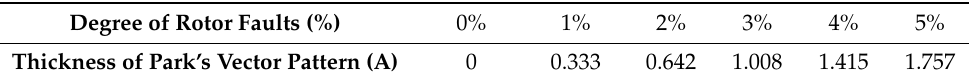
Figure 15. Park’s vector trajectories of a motor at nominal load and under different fault degree conditions: ( a ) healthy motor, ( b ) under 1% degree of fault, ( c ) under 2% degree of fault, ( d ) under 3% degree of fault, ( e ) under 4% degree of fault, and ( f ) under 5% degree of fault. Table 5. The thickness of the Park’s vector pattern of a motor at nominal load and under different degrees of rotor fault conditions.